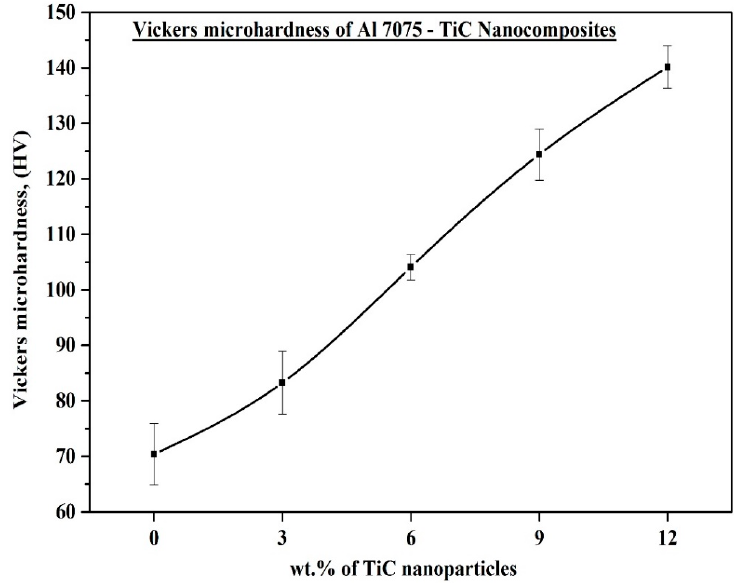
Figure 7. Vickers microhardness of Al–TiC nanocomposites.